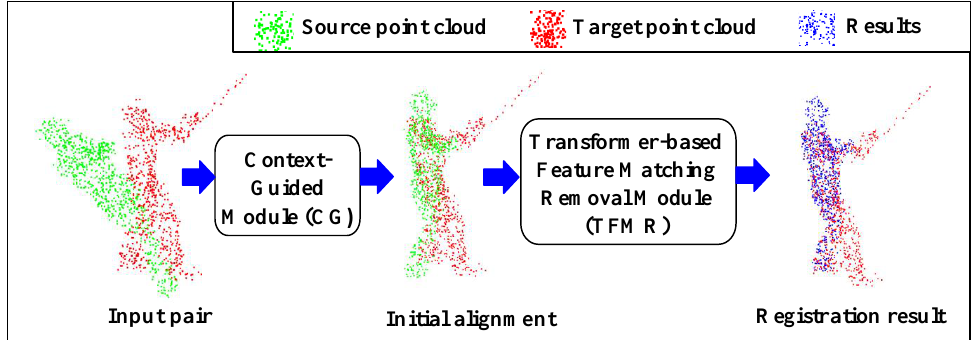
Figure 1. The original point cloud registration model of